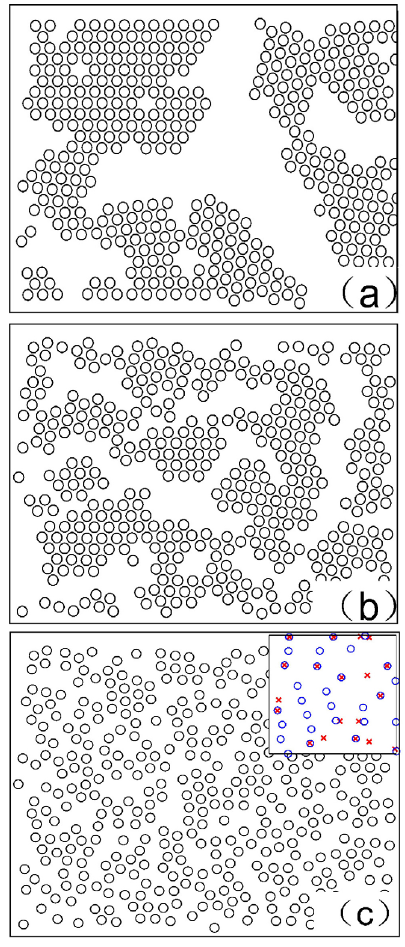
Fig. 2 Coordinates of colloidal particles for (a) (b) 0.5, and (c) 5. The inset of (c) shows a snapshot of (c), with the substrate pinning centers denoted by crosses, and free colloidal particles are clearly visible in the channels within different pinning